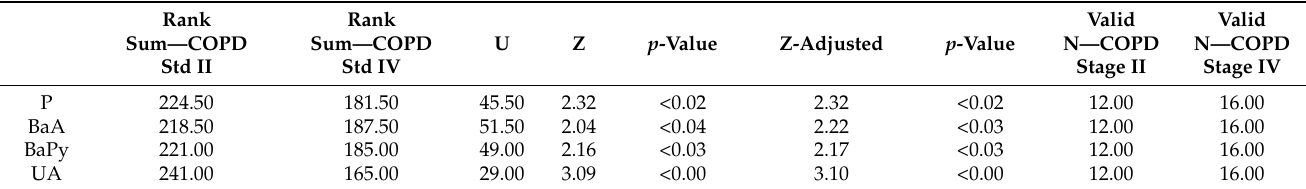
Table 7. Mann–Whitney U test applied to contents of PAHs and biochemical parameters in the case of the COPD group.